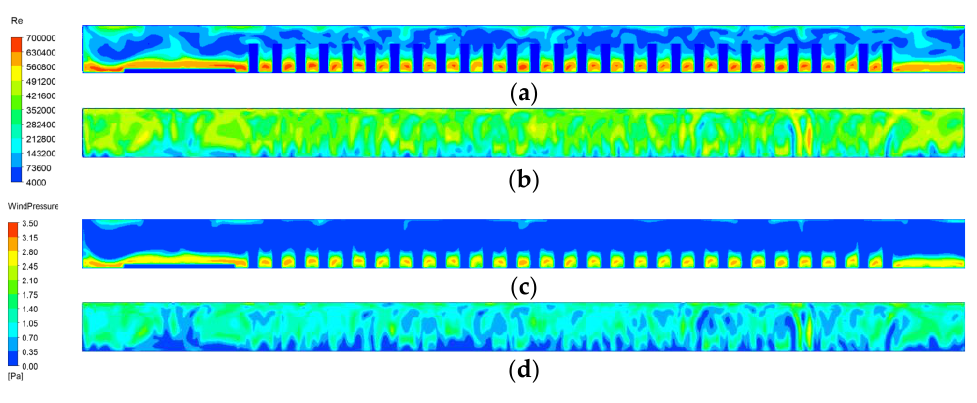
Figure 9. Wind pressure ventilation characteristics in the plain area of: ( a ) x = 4000 mm, Re; ( b ) x = 600 mm, Re; ( c ) x = 4000 mm, wind pressure; ( d ) x = 600 mm, wind pressure.